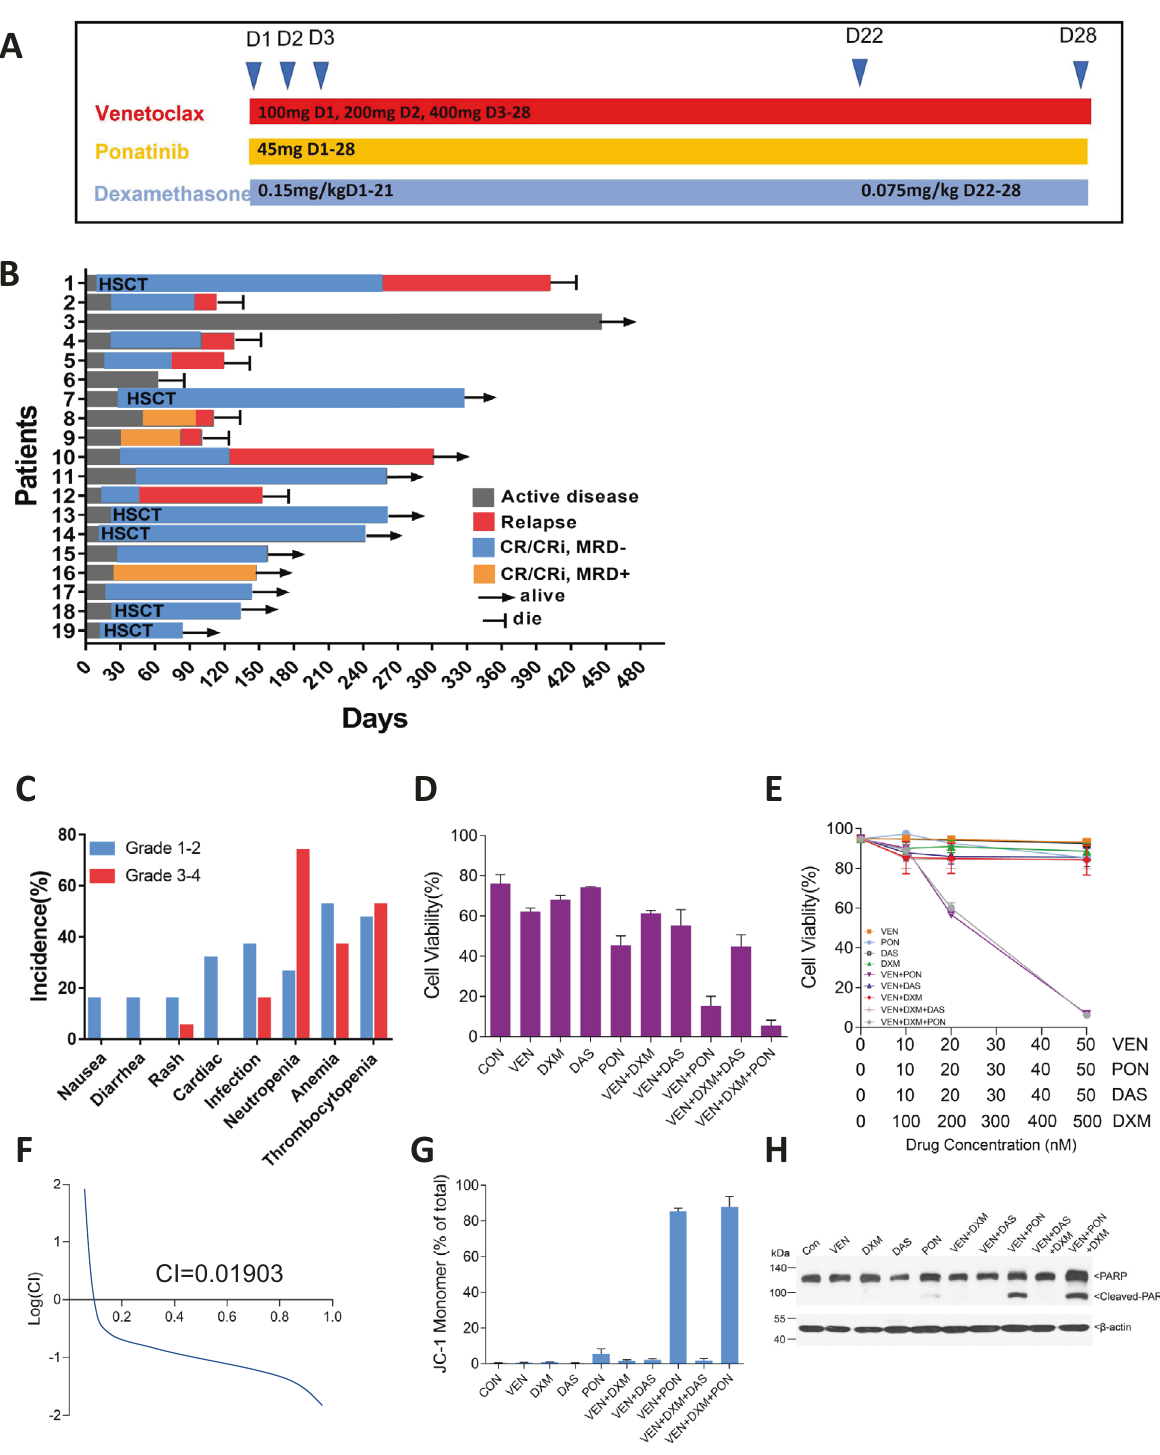
Fig. 1 Clinical response and In vitro results of the VPD regimen. A Trial scheme. B Shown is the clinical outcome for the 19 refractory/ relapsed Ph + ALL patients with T315I or compound mutation who were treated with a VPD regimen. Response assessments were performed according to the NCCN guidelines Acute Lymphoblastic Leukemia (version 2. 2021). The indicated responses include a complete response (CR) and CR with incomplete count recovery (CRi). C Adverse Events of VPD regimen. D Mononuclear cells separated from one Ph + ALL patient harboring T315I mutation were treated with venetoclax (VEN), ponatinib (PON), dasatinib (DAS), dexamethasone (DXM) alone or in combination at the indicated concentrations for 24 h. Apoptosis, as indicated by fl ow cytometry after Annexin V/PI double staining. E – H BaF3 cells expressing p190 BCR-ABL T315I mutation were treated with VEN, PON, DAS, DXM alone or in combination at the indicated concentrations for 24 h. Apoptosis, as indicated by fl ow cytometry after Annexin V/PI double staining ( E ), combination index (CI) of three drugs by using CompuSyn software ( F ), mitochondrial were stained with JC-1 ( G ), and western-blot analysis of PARP and cleaved-PARP expression ( H ). Notes: MRD minimal residual disease, as assessed by fl ow cytometry. HSCT hematopoietic stem-cell